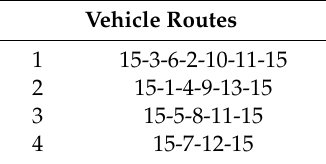
Table 3. Solution representation for the example problem.